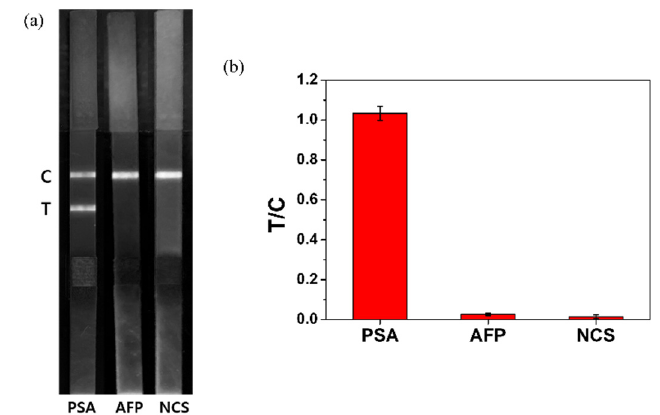
Figure 4. ( a ) Fluorescence image showing only the red channel of the test strip after the develop- ment of PSA, alpha-fetoprotein (AFP), and newborn calf serum (NCS) under a 365 nm UV lamp for the selectivity test; ( b ) T/C value of PSA, AFP, and NCS in strip